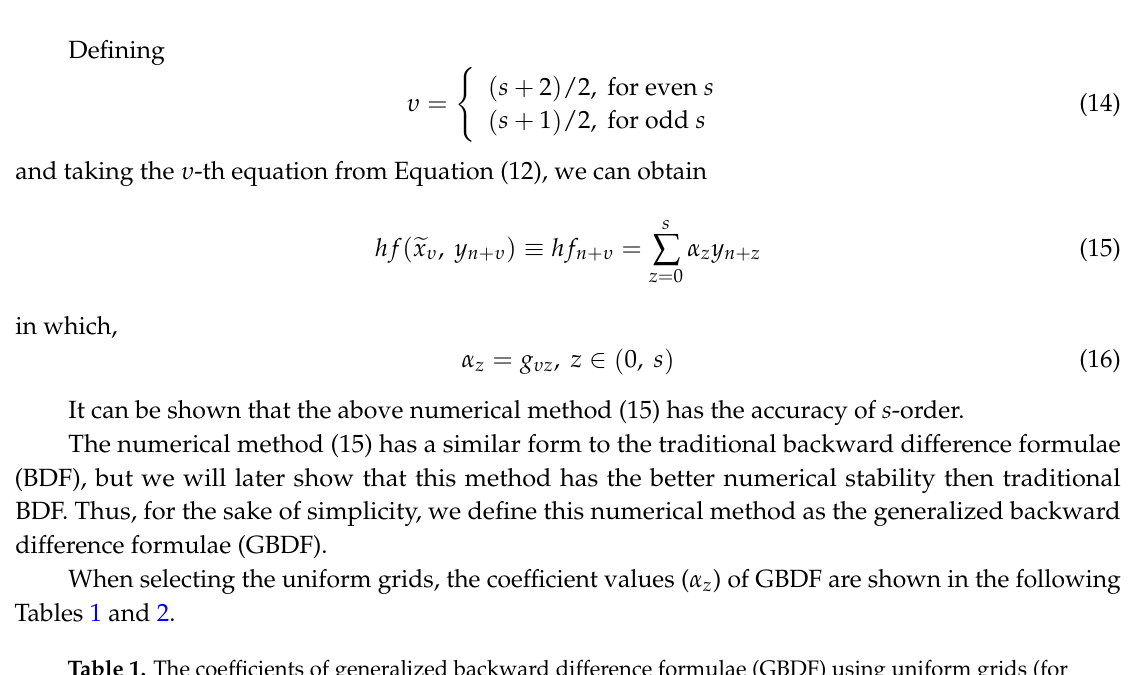
Figure 1. Schematic diagram of the grid points for generalized backward difference formulae (GBDF).